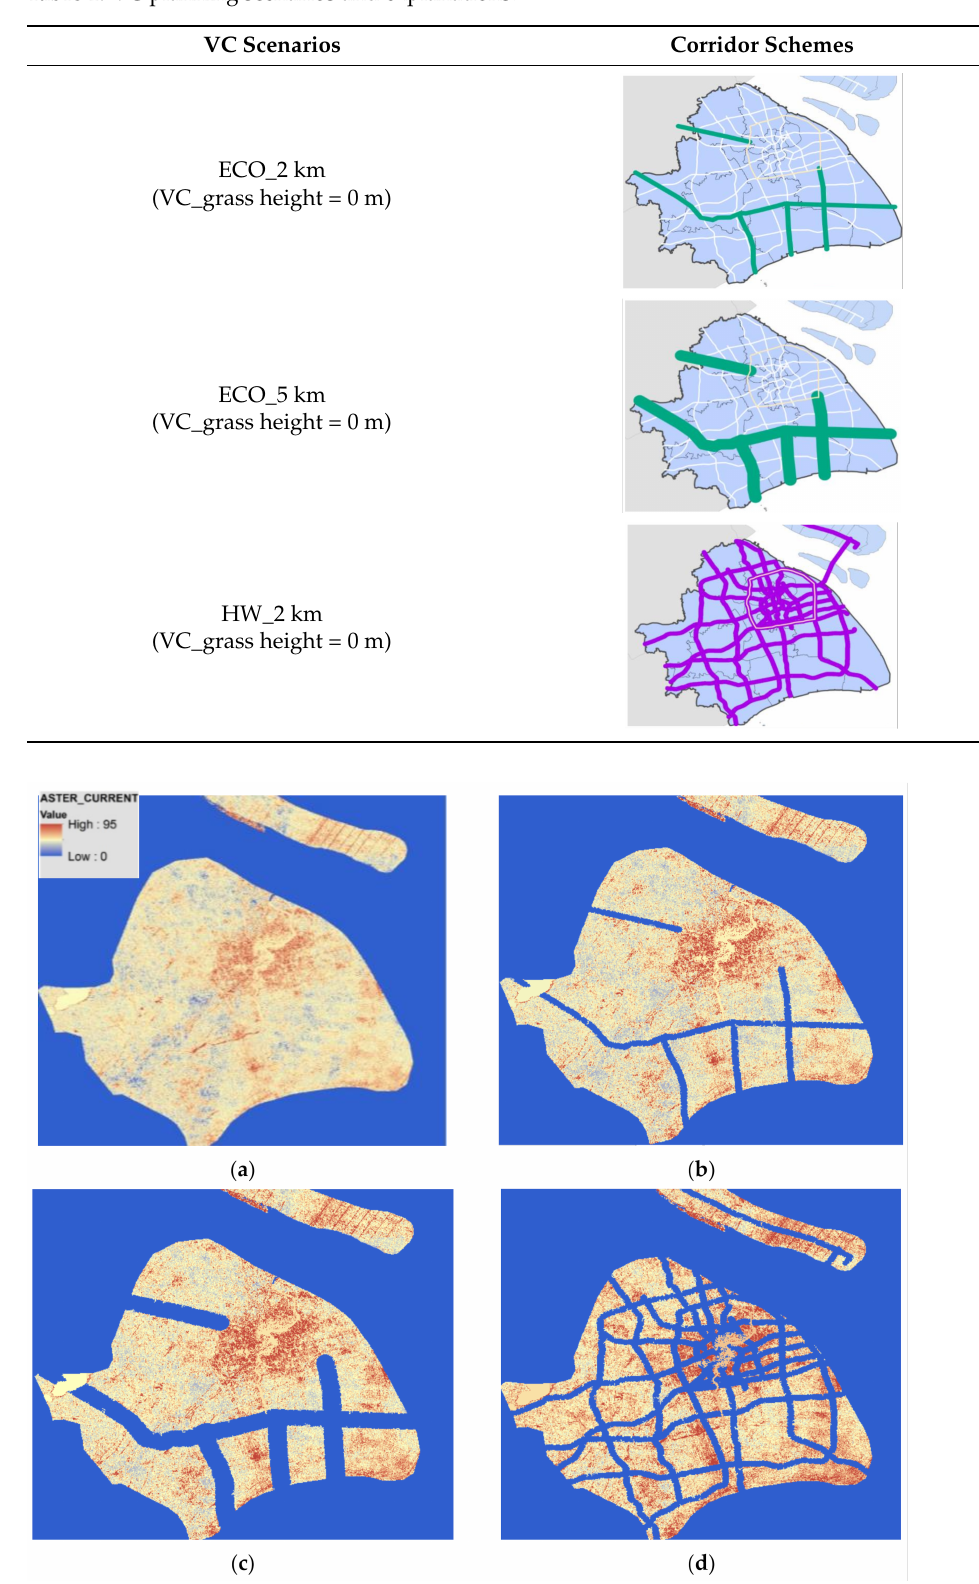
Table 1. VC planning scenarios and explanations.